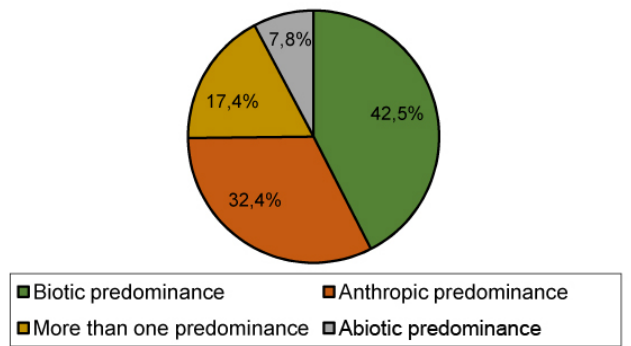
Figure 4: Overview of Level I landscape classification: predominance of main